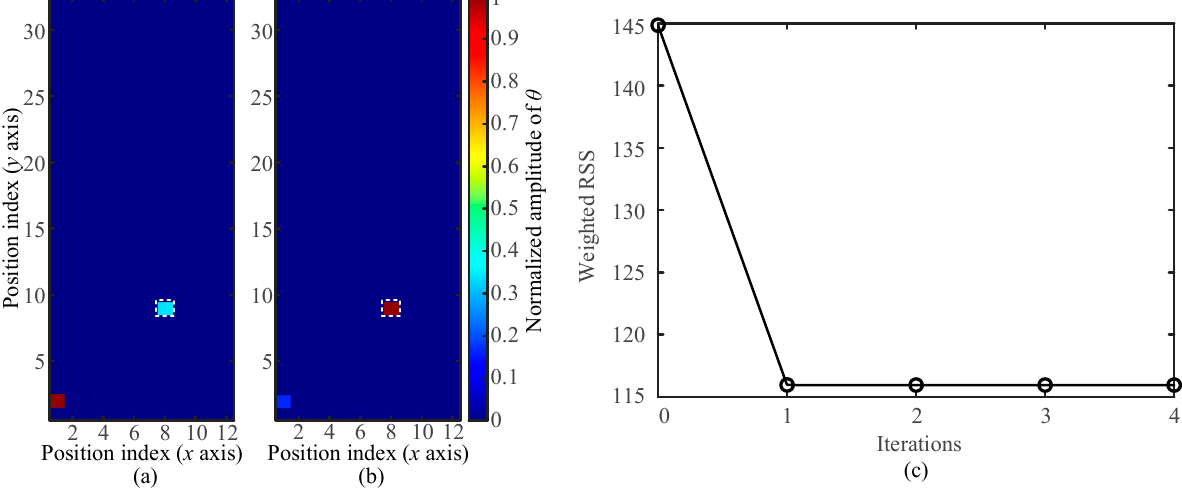
Figure 5. Performance comparison between the conventional and updated strategies in an unknown touch location: ( a ) and ( b ) touch location results, respectively, obtained with randomly and self-adaptively selected weight coefficients and ( c ) the value of weighted RSS in four iteration steps.